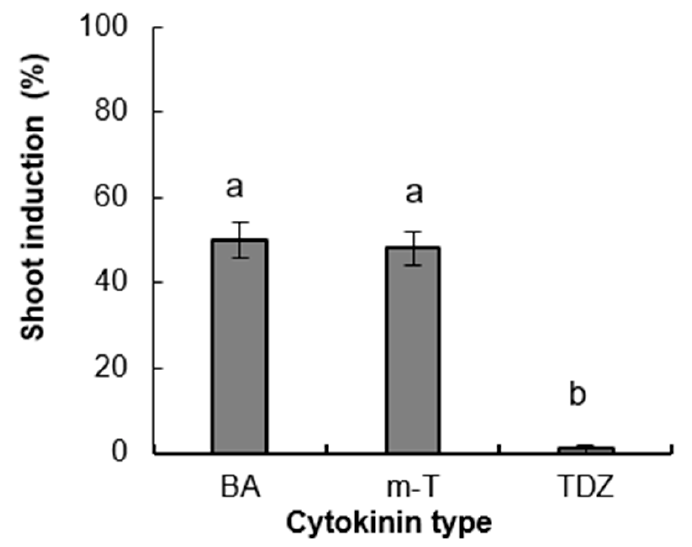
Figure 7. Shoot induction (%) in explants of Cryptomeria japonica cultured on QL medium [15], supplemented with 6-benzyladenine (BA), meta-topolin (m-T), and thidiazuron (TDZ) (8.8 µ M). Data are presented as mean values ± S.E. Significant differences are indicated by different letters according to Tukey’s post hoc test ( p < 0.05).